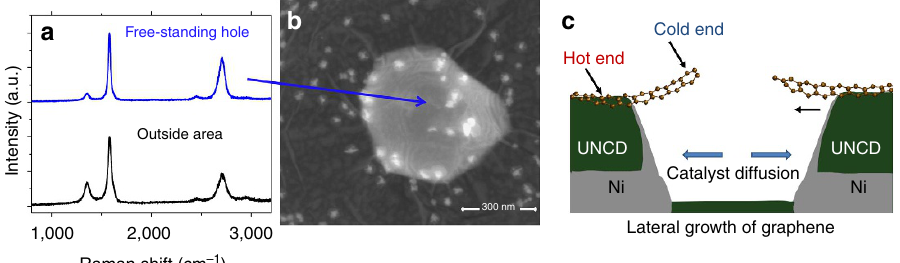
Figure 6 | Growth mechanism of free-standing graphene. ( a ) Changes in the intensities of D and 2D peaks for Raman signature of the graphene on the hole (from I D / I G ¼ 0.3 and I 2D / I G ¼ 0.4 outside the hole to I D / I G ¼ 0.1 and I 2D / I G ¼ 0.6) indicate growth of the free-standing graphene. ( b ) The Raman signature of graphene grown directly on UNCD (outside area) is provided for the reference. ( c ) The schematic of mechanism of free-standing graphene growth is presented.